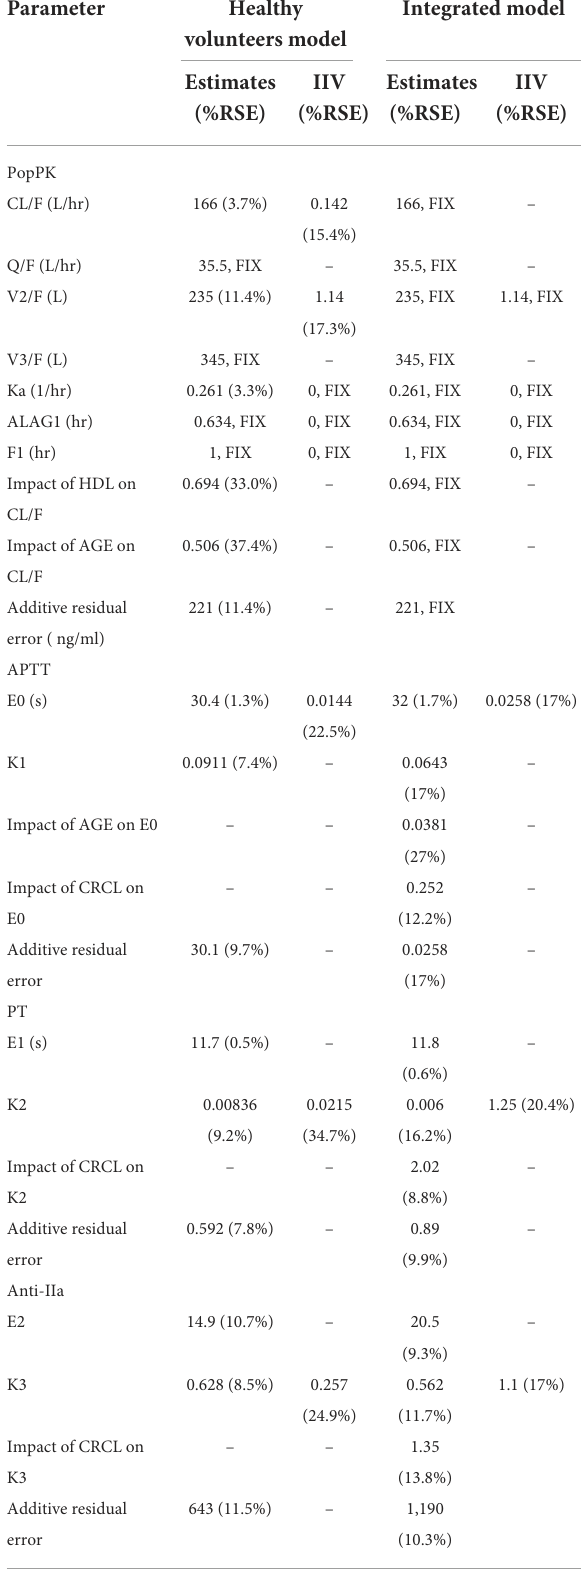
TABLE 2 Final population estimates for parameters of healthy volunteers and patients in the integrated model. Parameter A linear direct effect model with additive error best describes the relationship between APTT and dabigatran plasma concentration. Table 2 sums up the PD modeling results